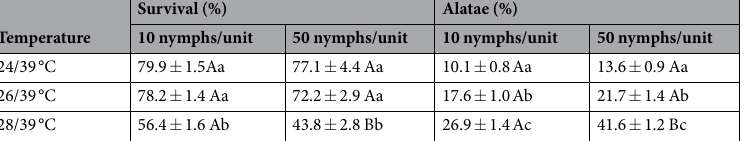
Table 4. The percentage of survival and alatae (mean ± SE%) of Rhopalosiphum maidis under different temperature and density combinations. Within a row, different lowercase letters indicate significant differences ( P < 0.05) by using Tukey’s multiple range tests; Within a column, different uppercase letters indicate significant differences ( P < 0.05) by using Tukey’s multiple range